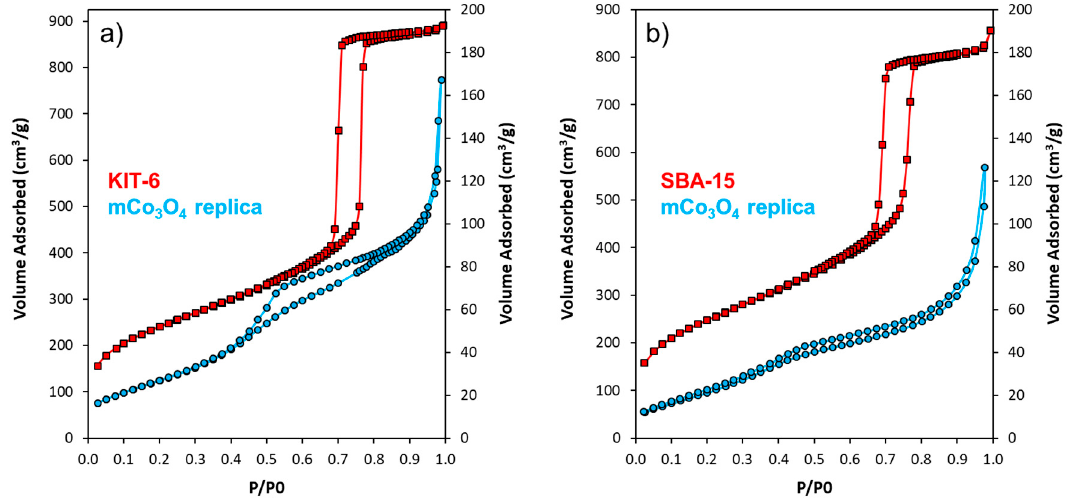
Figure 2. N 2 adsorption-desorption isotherms at − 196 °C of KIT-6 silica ( a ), SBA-15 silica ( b ) and the respective nanocast mesoporous Co 3 O 4 replicas (scaled on a second y -axis for clarity, on the right).